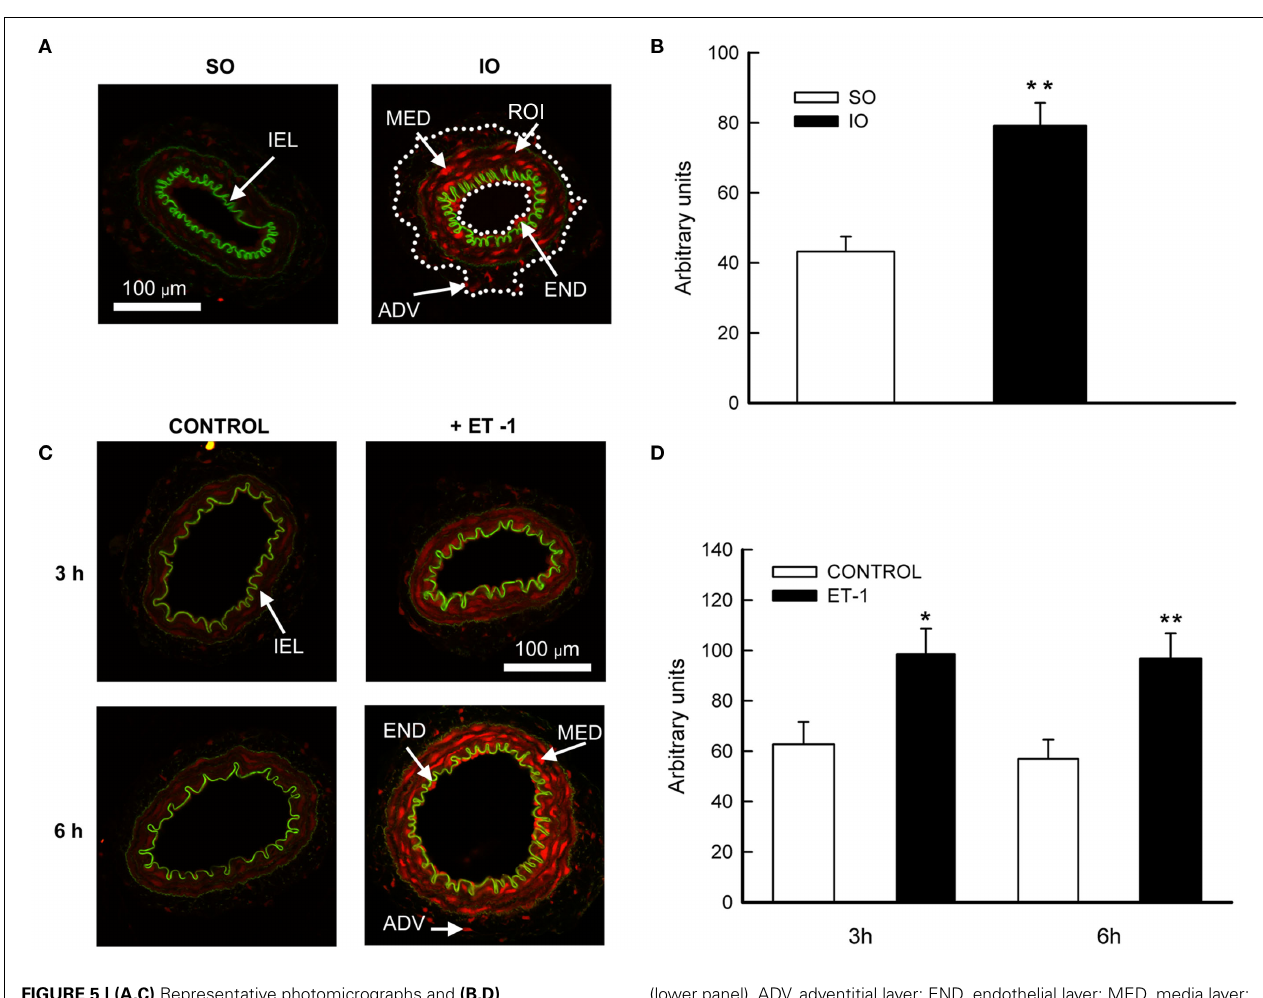
FIGURE 5 | (A,C) Representative photomicrographs and (B,D) quantification of ethidium bromide fluorescence by confocal microscope in sections of mesenteric resistance arteries from SO and IO rats (upper panel); or in cultured mesenteric resistance arteries from non-operated rats incubated with or without ET-1